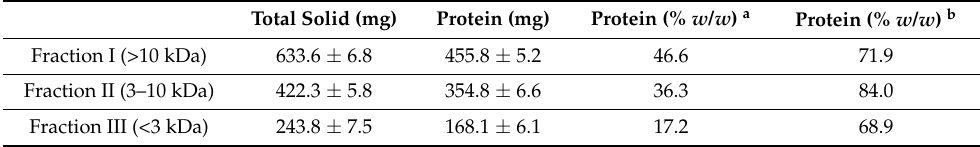
Table 2. RPI (DH1) fractionation by ultrafiltration and peptide